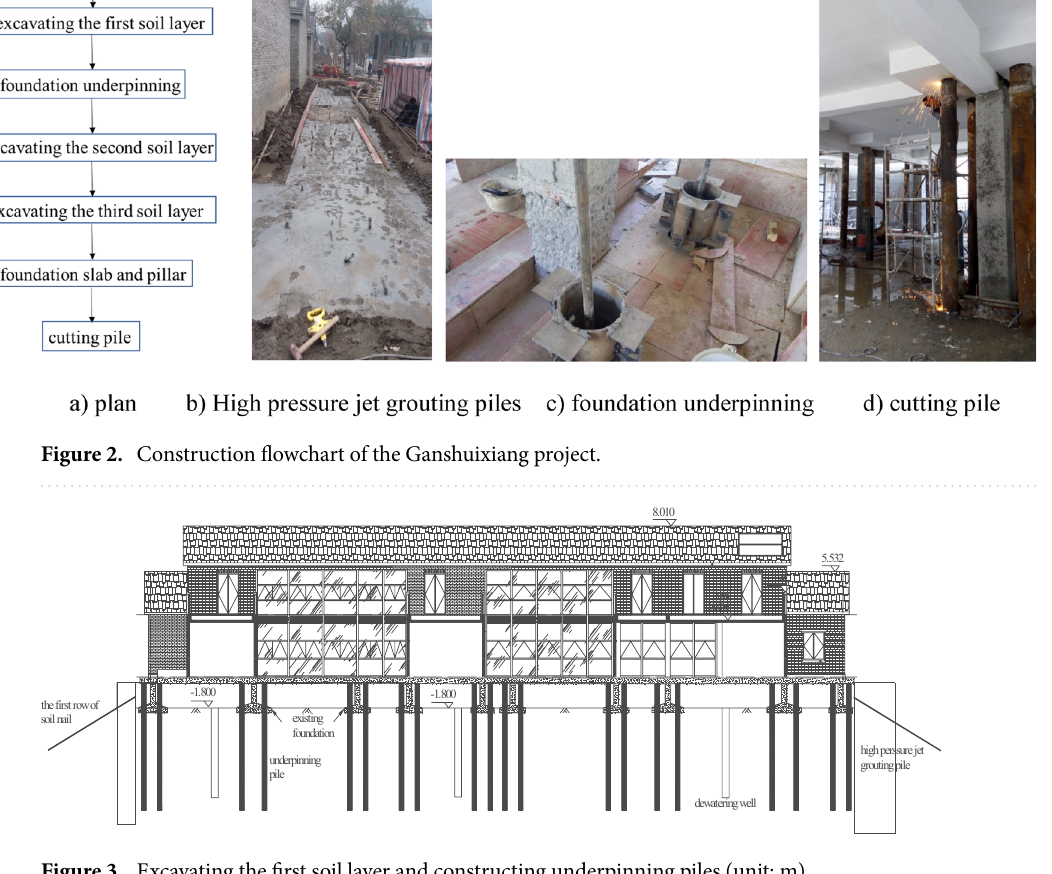
Figure 3. Excavating the first soil layer and constructing underpinning piles (unit: